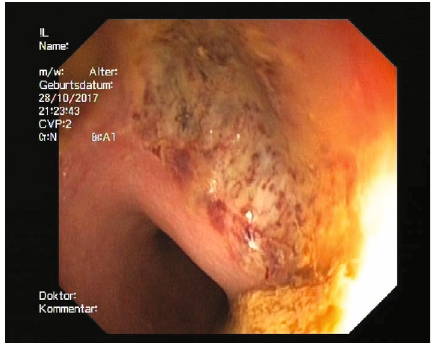
Figure 3: Hematoma in colonoscopy.